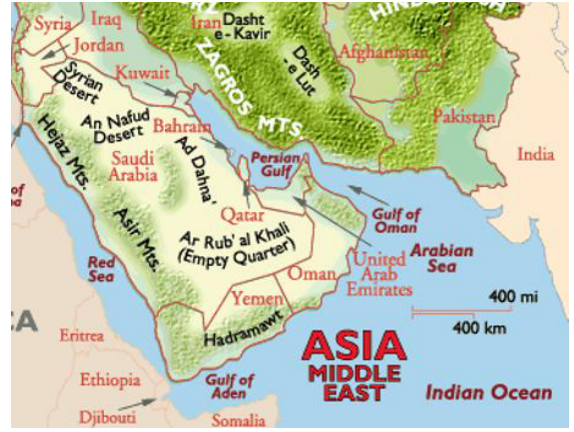
Figure 1. Topography of the Arabian Peninsula [17].